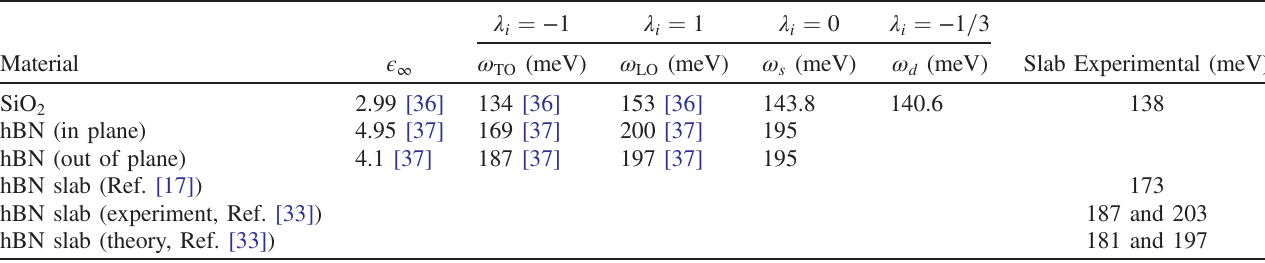
− 1 ; 1 ; 0 ; − 1 = 3 (charge-symmetric or charge-antisymmetric TABLE II. Comparison of theoretical and experimental values for λ i ¼ modes for infinitely thin slabs or cylinders, surface mode, dipolar spherical mode) and experimental values from Refs. [17,33]. In the latter case, two modes (interpreted as charge-symmetric and charge-antisymmetric FK modes) are reported.